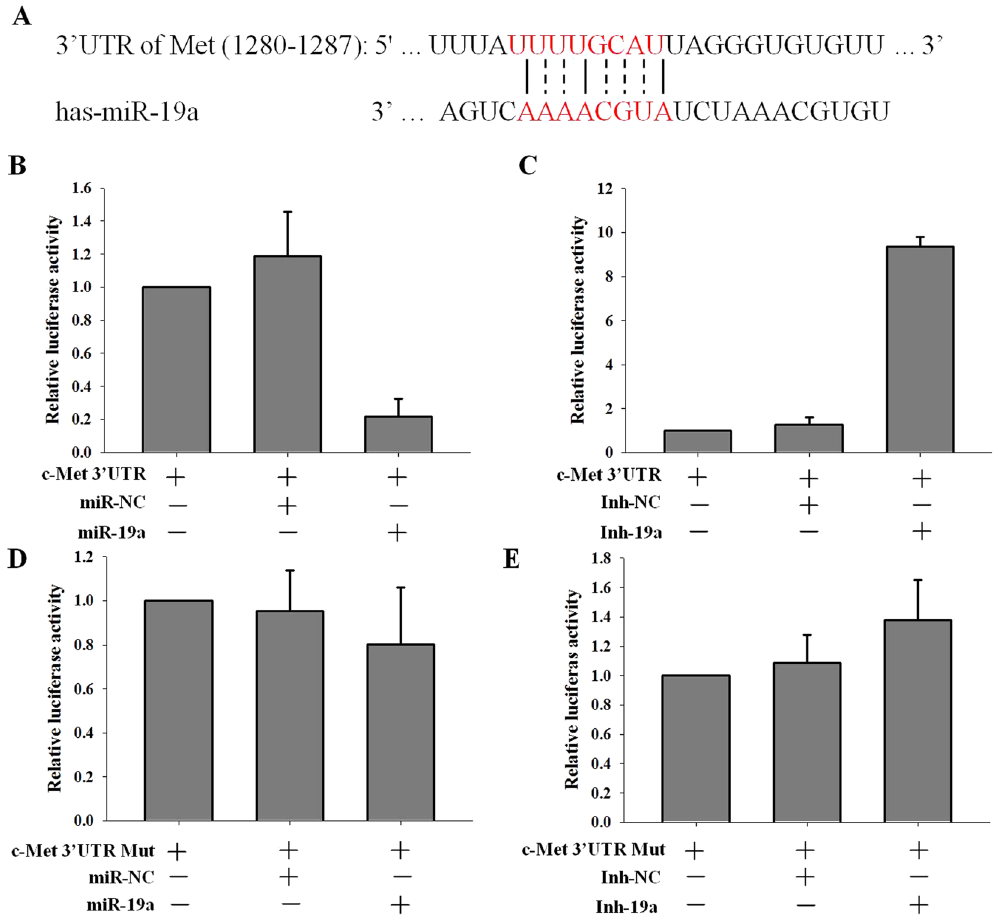
Figure 5. miR-19a regulates c-Met by targeting its 3 ′ UTR. Schematic representation of the 3 ′ UTR of c-Met with the predicted target site for miR-19a. The mutant site of c-Met 3 ′ UTR is indicated (dotted line); ( B , C ) Reporter constructs containing the wild-type c-Met 3 ′ UTR were co-transfected into Pc9 cells along with miR- 19a or miR-NC ( B ) or Ihn-19a or Inh-NC ( C ); the relative luciferase activity was measured (mean ± sd, n = 3, ** p < 0.01). ( D , E ) Reporter constructs containing the c-Met 3 ′ UTR harboring a mutation at the predicted miR- 19a target sequence were co-transfected into Pc9 cells with miR-19a or miR-NC. The same construct was co- transfected with Inh-19a or Inh-NC; the relative luciferase activity was measured (mean ± sd, n = 3, ** p <